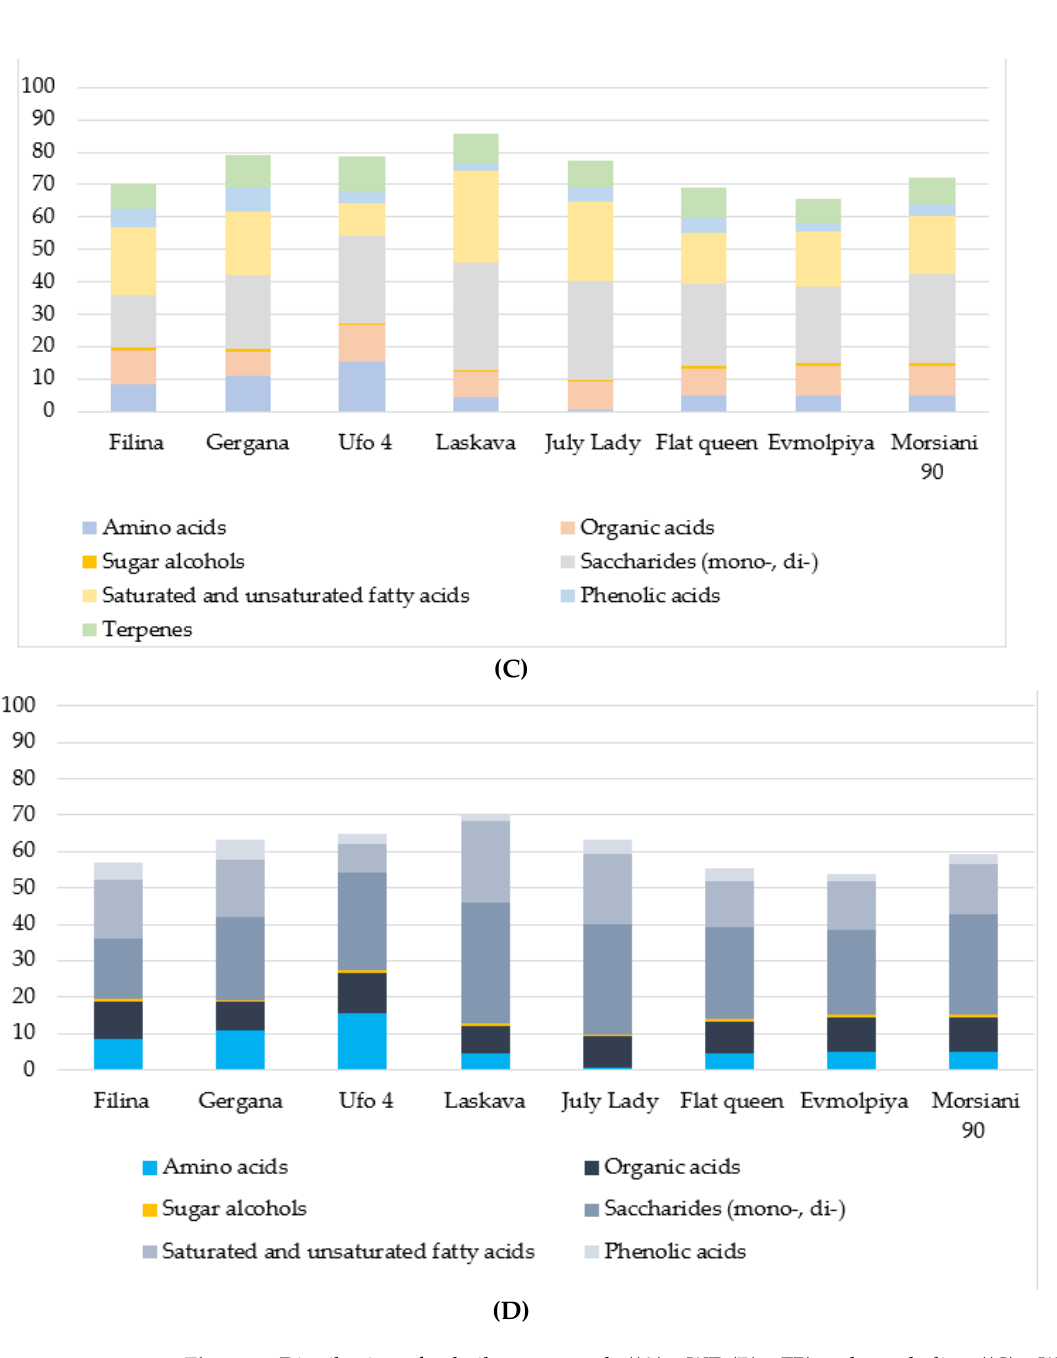
Figure 1. Distribution of volatile compounds (( A )—WF, ( B )—FP) and metabolites (( C )—WF, ( D )—FP) according to their chemical families in eight peach cultivars.